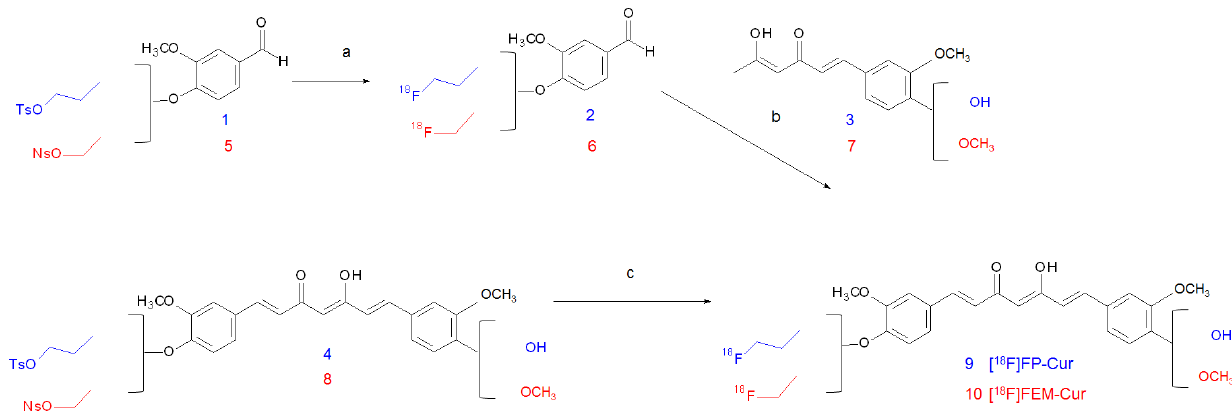
Figure 1. Reagents and conditions: ( a ) n-Bu 4 N[ 18 F]F, CH 3 CN, 120 °C, 15 min; ( b ) B 2 O 3 , (n-BuO) 3 B, piperidine, ethyl acetate, 120 °C, 20 min, 0.4 N HCl, 90 °C, 5 min; ( c ) n-Bu 4 N[ 18 F]F, THF, 95 °C, 20 min.